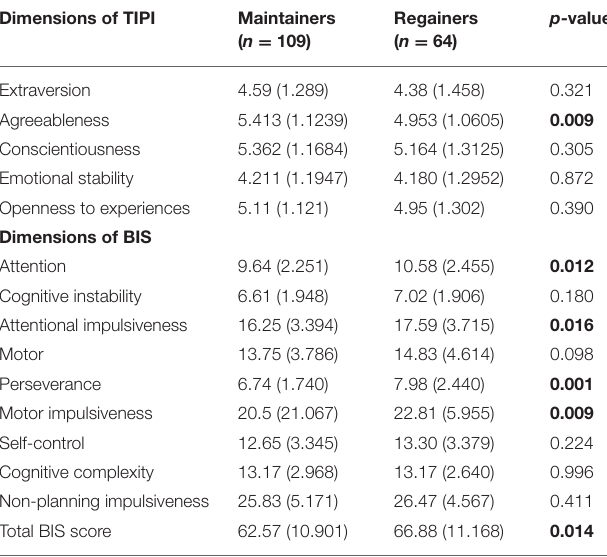
TABLE 2 | Comparison of personality traits between maintainers and